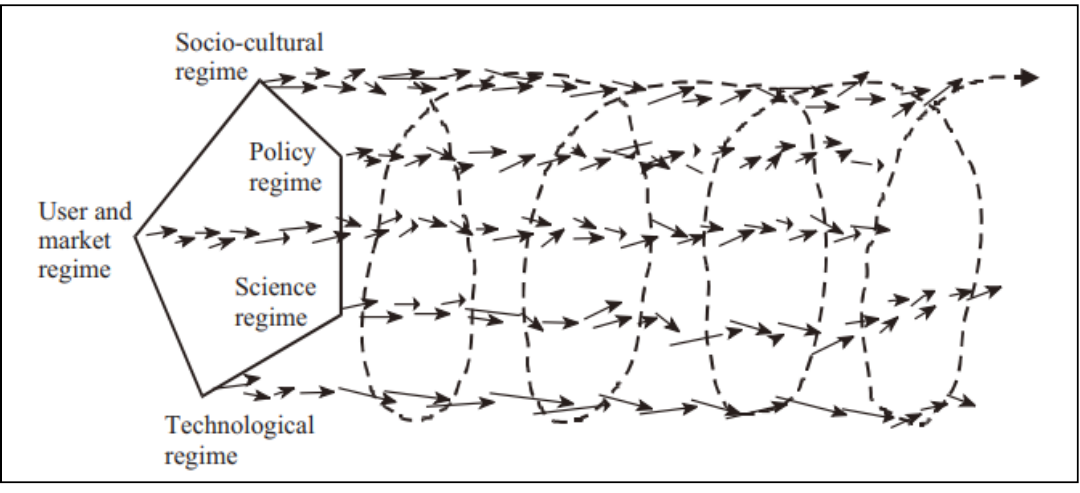
Figure 1. Coexistence of different currents in a socio ‐ technological regime [24].